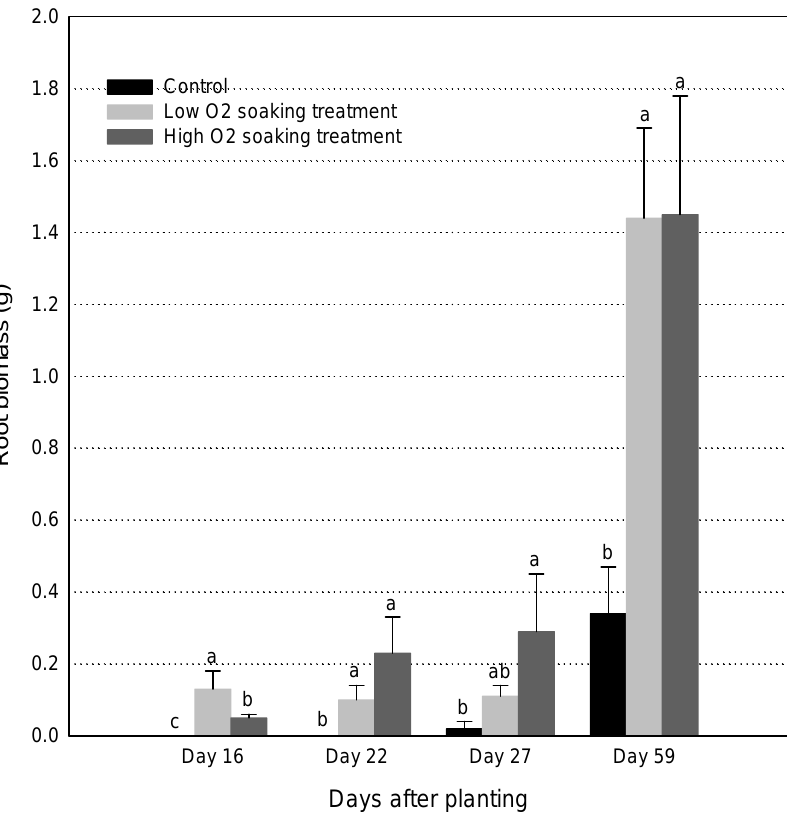
FIGURE 2. Mean root biomass (g, ± s.e.) of black willow ( S. nigra ) cuttings in control, low O 2 and high O 2 soaking treatment groups for combined subsampling data on days 16, 22, 27, and 59 after planting (n = 27). Different lower case letters above each bar represent significant differences between treatment groups ( p ≤